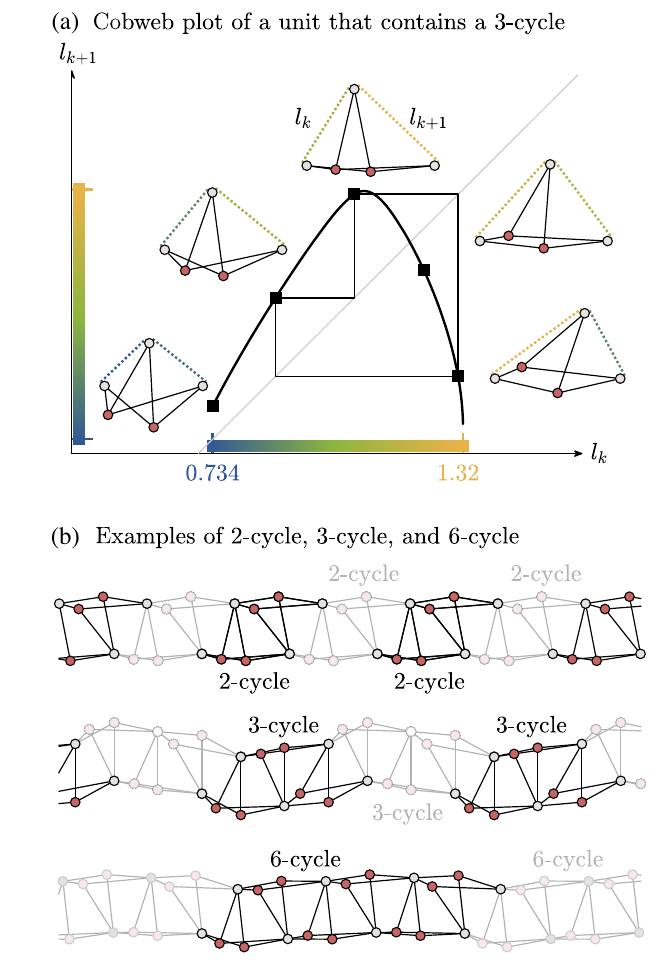
FIG. 13. A 3-cycle unit. (a) Cobweb plot of a unit containing a 3-cycle. (b) Examples of 2-cycle, 3-cycle, and 6-cycle confor- mations that can be found in this